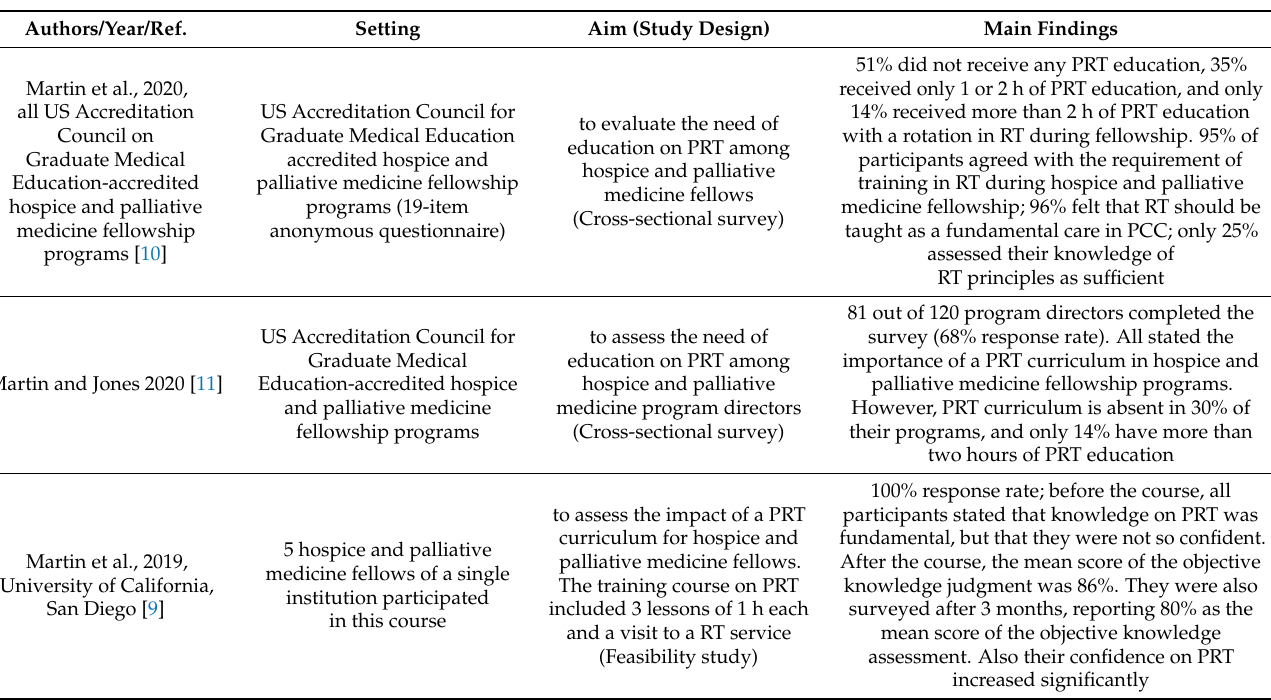
Table 4. Characteristics and main findings on studies about education and training of experts in supportive